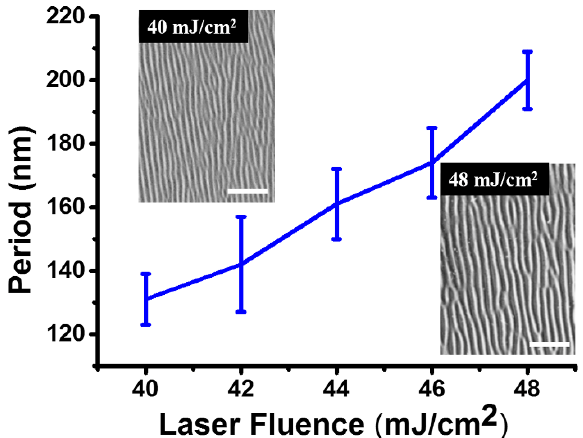
Figure 9. Measured variations of the structure period as a function of the incident laser energy fluence of two beams. Both upper-left and bottom-right insets show the SEM images (scale bar: 1 µ m) of the nanostructure under the laser fluences of F = 40 mJ/cm 2 and 48 mJ/cm 2 , respectively.